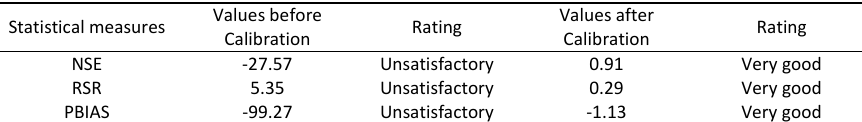
Table 2: Maradugao basin model performance rating Statistical measures